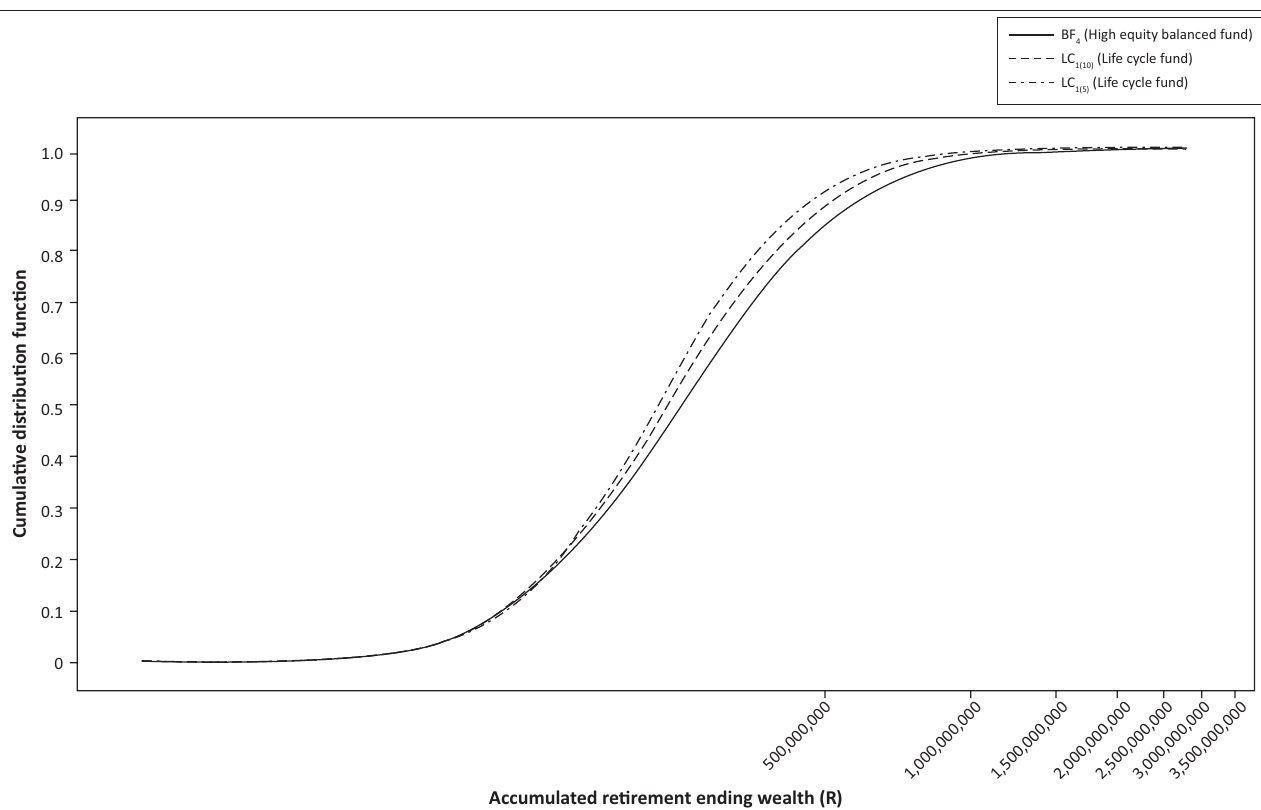
FIGURE 2: Cumulative distribution functions of accumulated retirement ending wealth for models LC